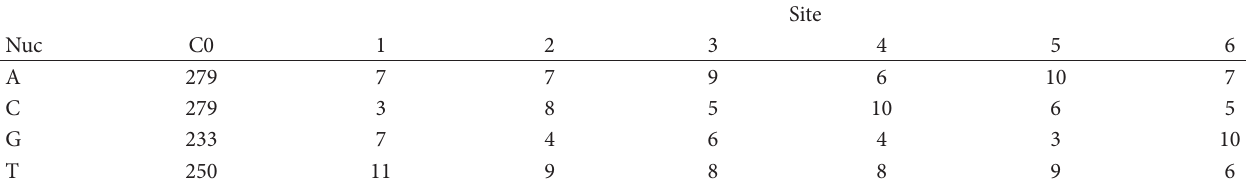
T 3: Site-speci�c distribution of nucleotides from the 28 random motifs of length 6, a�er remo�ing the initial motif in . e second column lists the distribution of nucleotides outside the 28 random